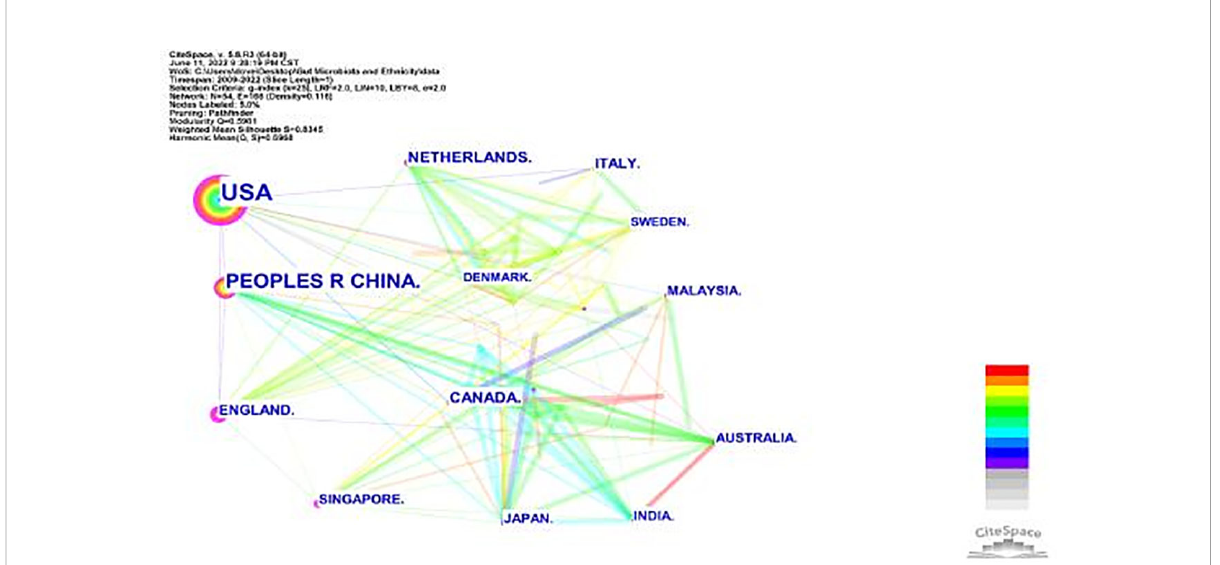
FIGURE 7 National co-occurrence network diagram. The larger the keyword node, the stronger its neutrality. The line of nodes represents the co- occurrence relationship, the thickness of the line indicates the intensity of co-occurrence. The color from gray to red indicates the time from early to recent. The fi gure shows the collaborative network between countries for journal articles related to minority gut